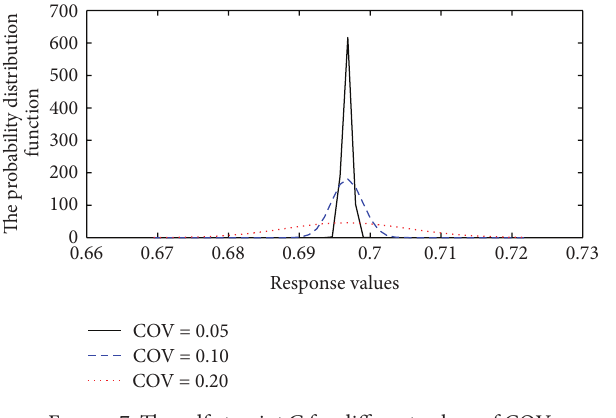
Figure 10: The pdf at point 𝐷 using SFDHC and